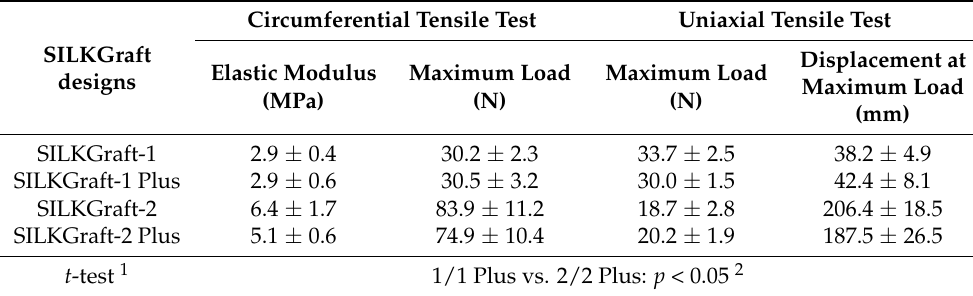
Table 4. Mechanical properties: circumferential and uniaxial tensile